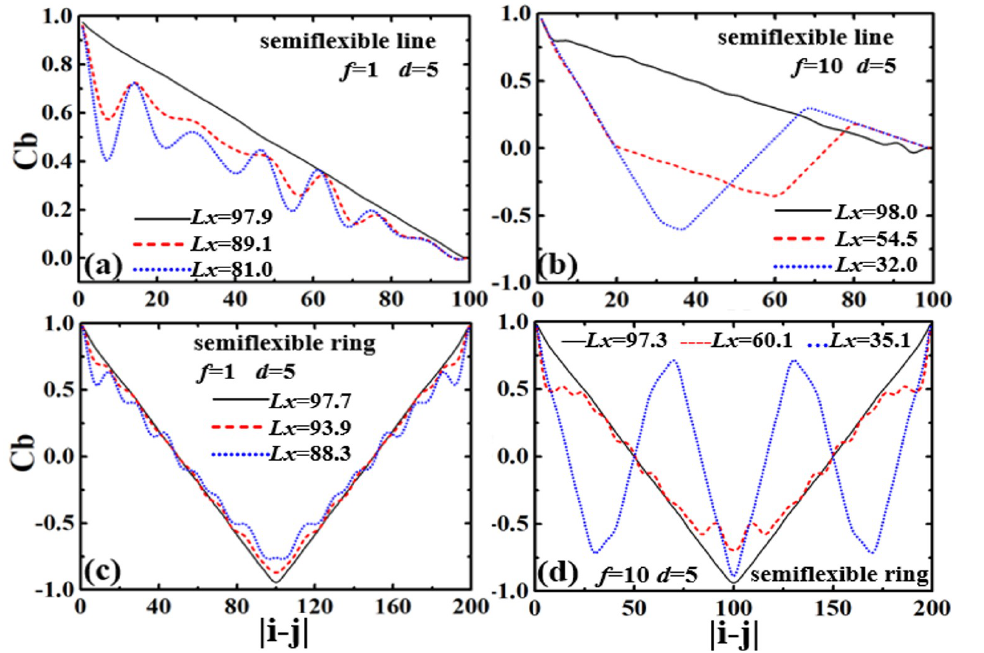
Figure 3. Bond correlation functions C b of confined semiflexible chains in the compression processes: ( a ) linear polymer within f = 1 and d = 5; ( b ) linear polymer within f = 10 and d = 5; ( c ) ring polymer within f = 1 and d = 5; and ( d ) ring polymer within f = 10 and d =